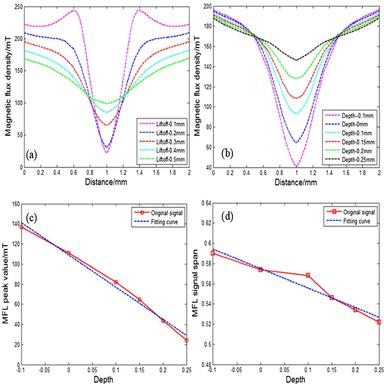
MFL signals and characterizations of arc-shaped defect; (a) MFL signals of arc-shaped defect in different liftoff values with the circle center depth of 0 mm; (b) MFL signals of arc-shaped defect in different circle center depths with the liftoff of 0.3 mm; (c) Relationships between MFL peak values in (b) and defect circle center depths; (d) Relationships between MFL signal spans in (b) and defect circle center depths.